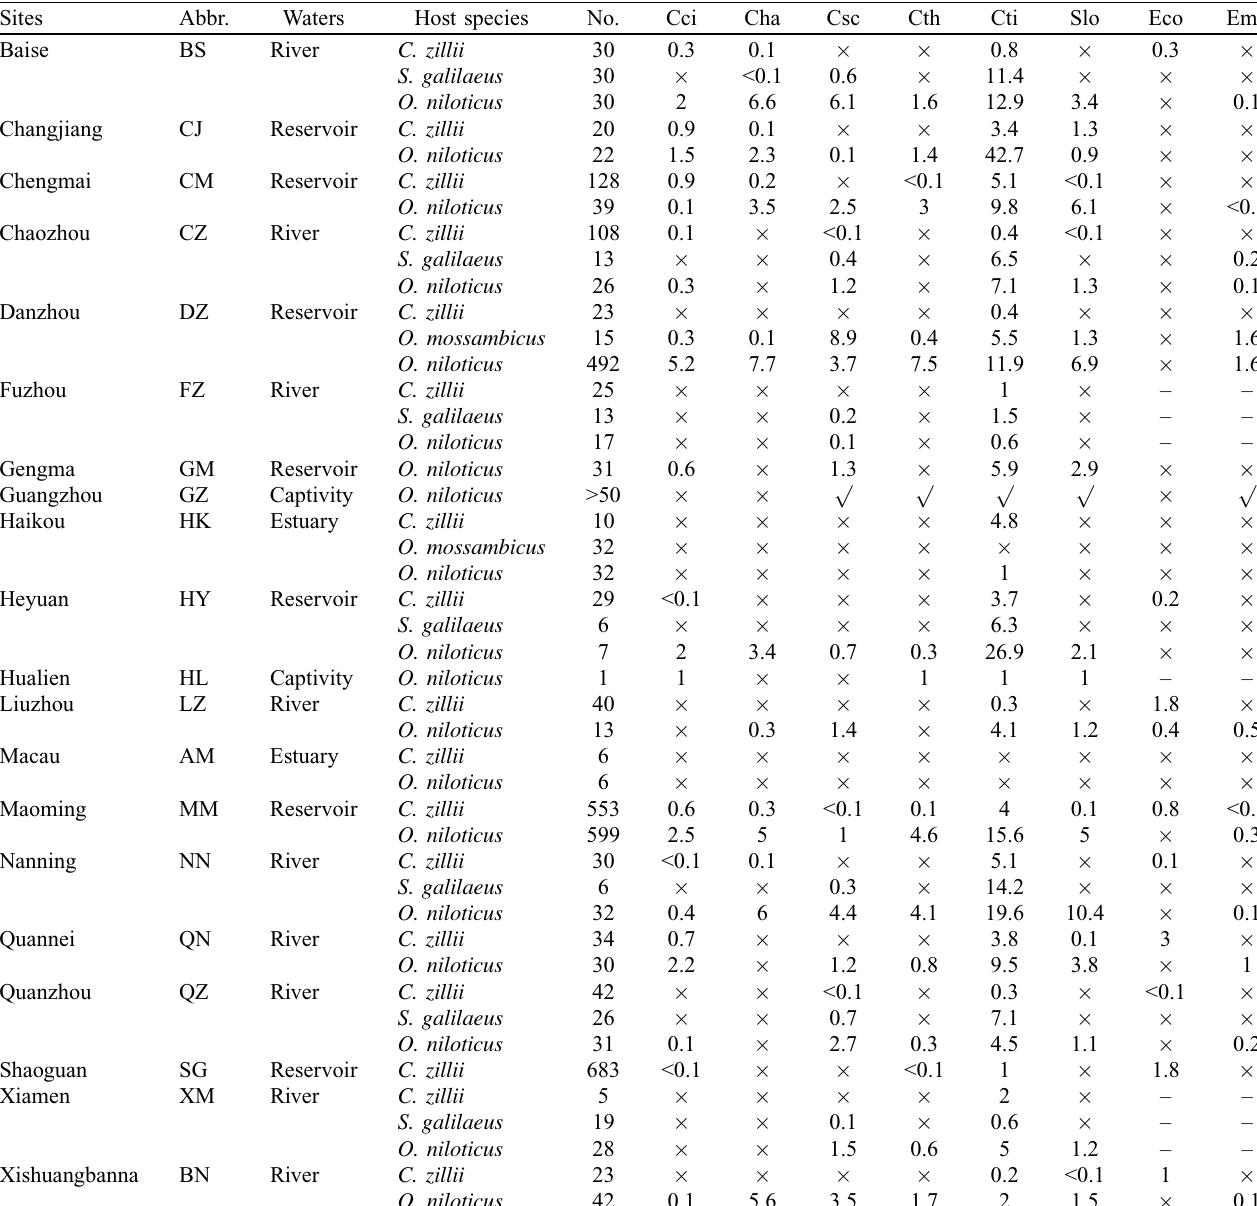
Table 1. Monogeneans of invasive tilapias with mean abundance in south China. Sites